Question: In one sentence, what is this figure communicating?
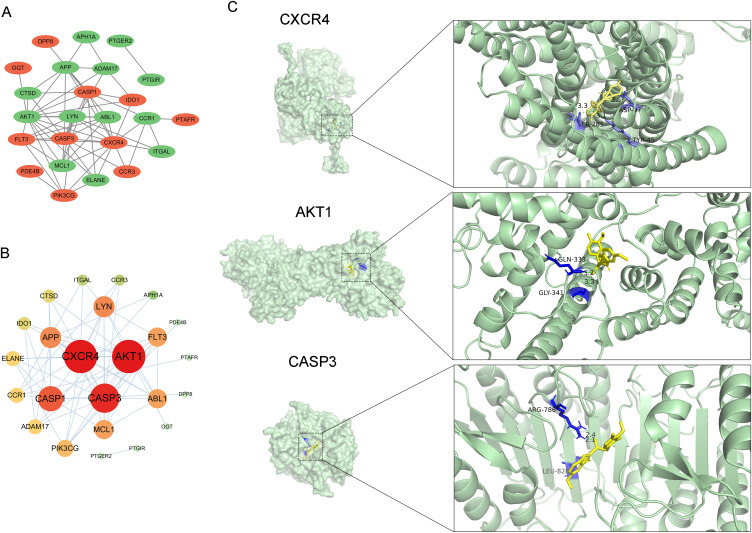
Answer: Protein-protein interaction network construction, hub gene identification, and molecular docking of esomeprazole with core targets. (A) Protein–protein interaction network of key genes associated with esomeprazole-related OP biological processes. red nodes represent upregulated genes; green nodes represent downregulated genes. (B) Core protein-protein interaction network construction derived from the degree centrality algorithm, highlighting hub genes shared between esomeprazole targets and OP-related DEGs. (C) Molecular docking models showing predicted binding poses of esomeprazole with the three candidate hub proteins: CXCR4, AKT1, and CASP3. Binding poses and interaction sites are displayed in 3D visualization.